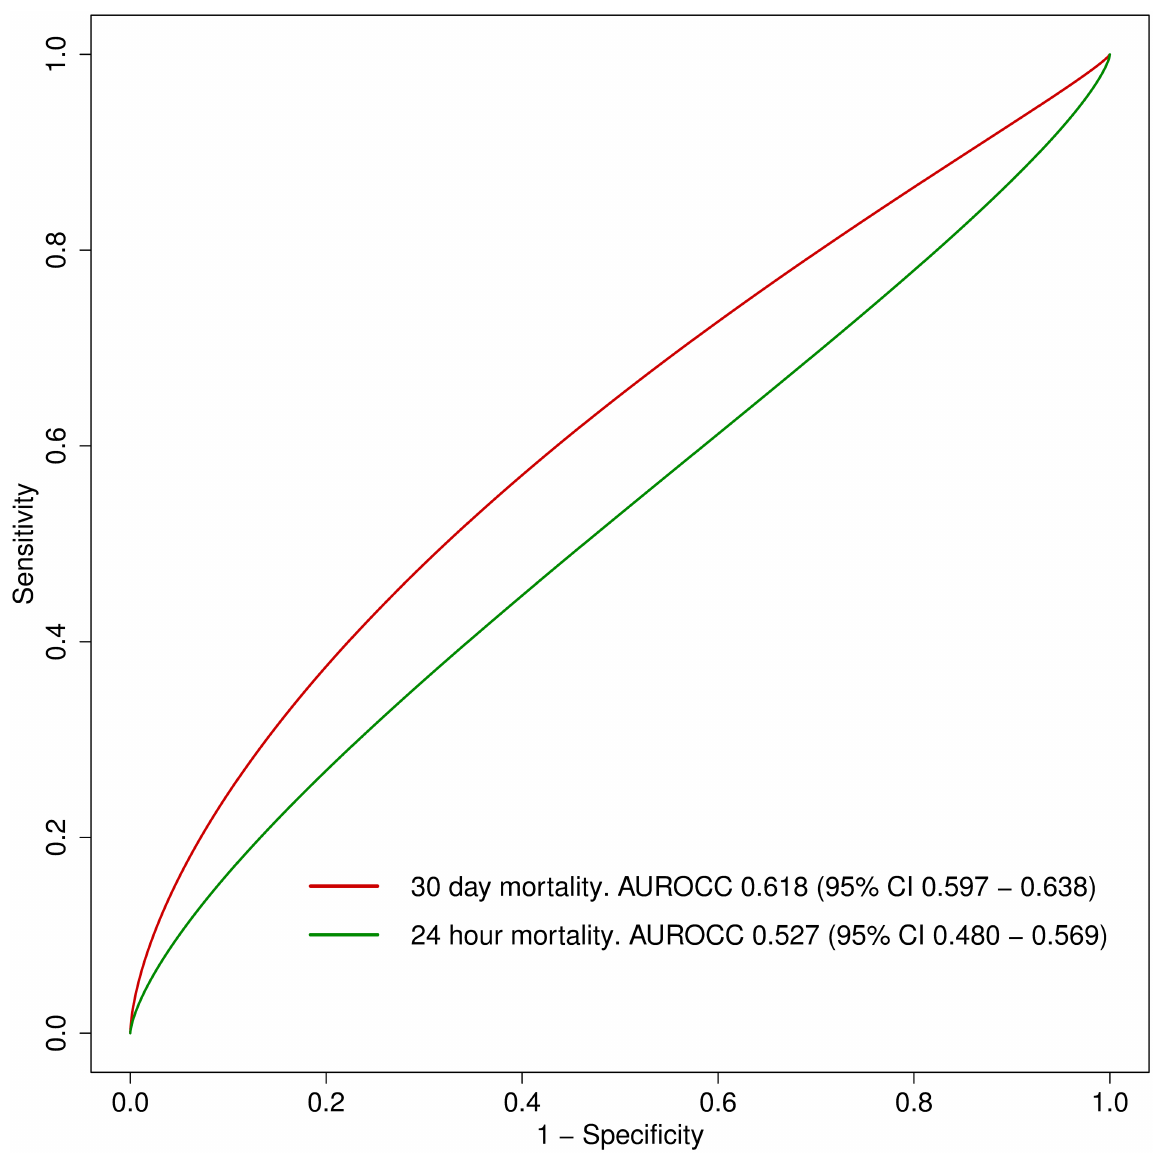
Fig 1. Area under the receiver operating characteristics curve (AUROCC) for ICISSm30d and